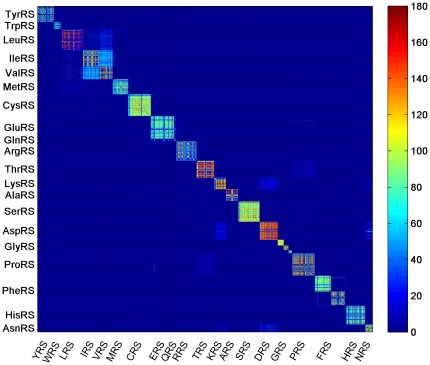
BLAST similarities between different aaRSs (log-scaled).E-values>0.01 are in blue.